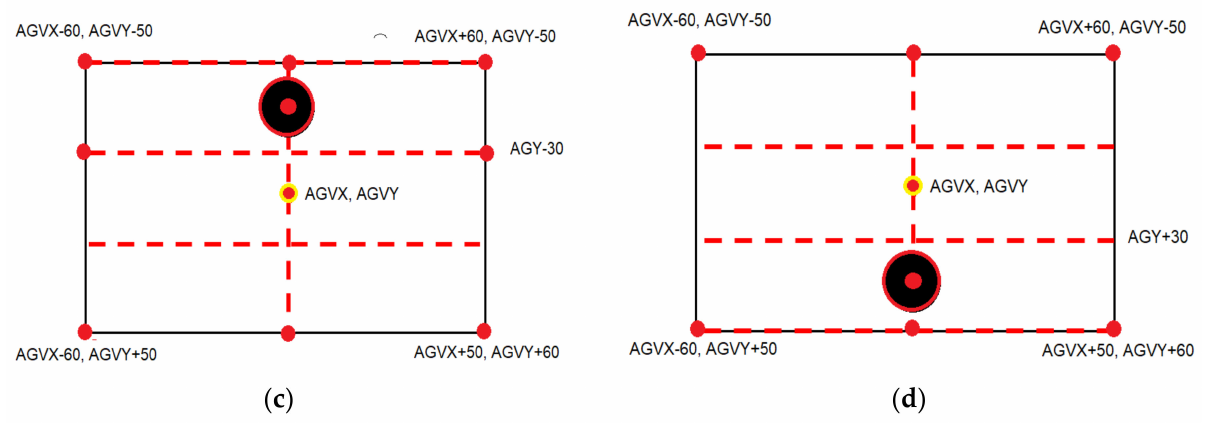
Figure 10. Eyeball direction encoding: ( a ) turn left, ( b ) turn right, ( c ) forward, and ( d ) backward.